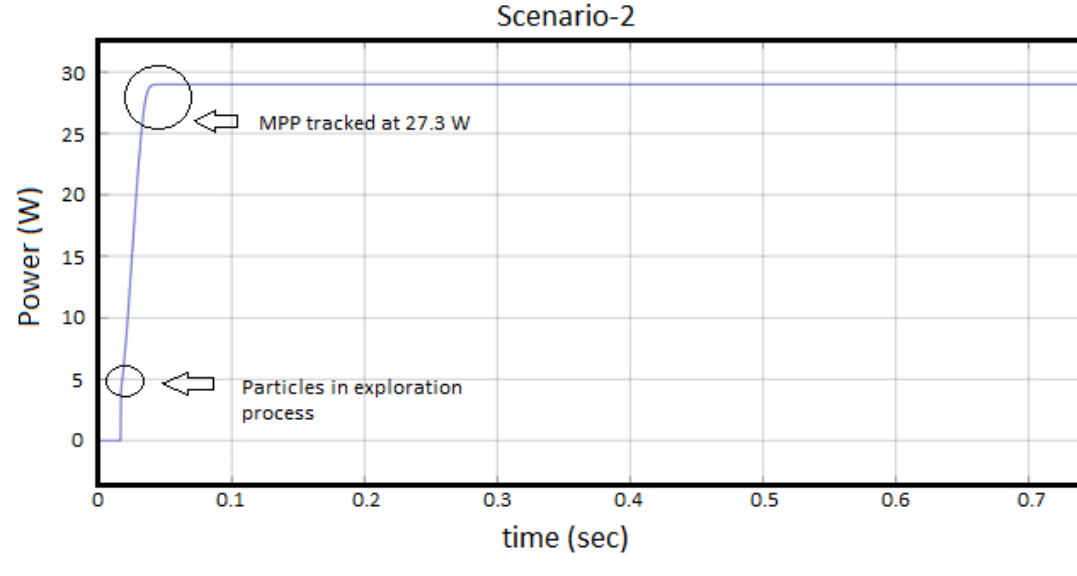
Figure 7. Performance of ICPSO under Scenario-2.